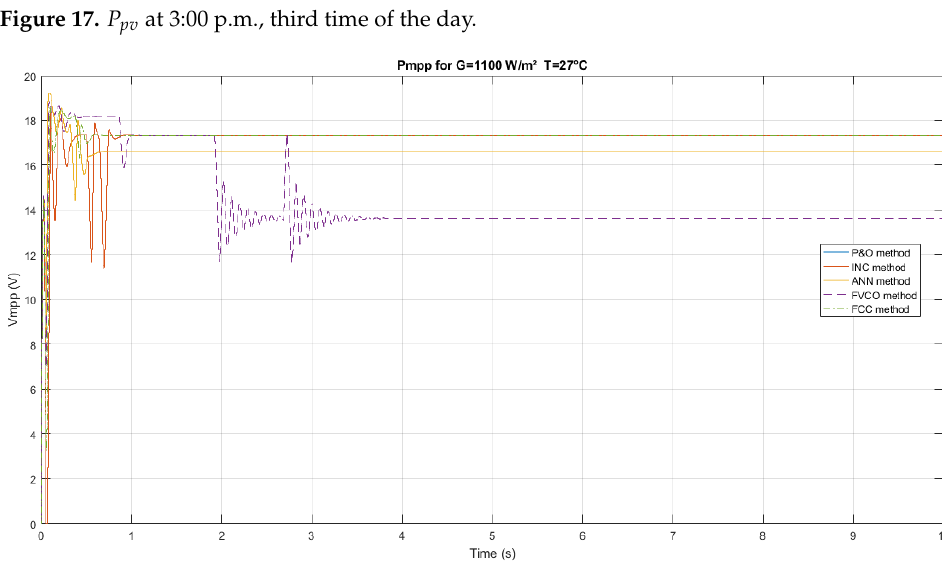
Figure 18. V pv at 3:00 p.m., third time of the day.